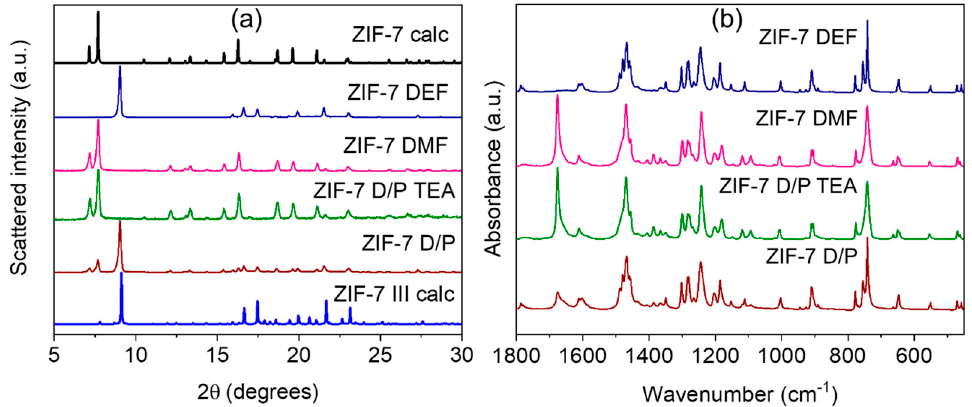
Figure 1. Powder X-ray diffraction (XRD) patterns ( a ) and FTIR-spectra ( b ) of synthesized samples. In part ( a ) “ZIF-7 calc” (black line) and “ZIF-7 III calc” profiles (blue line) were calculated according to crystallographic data from